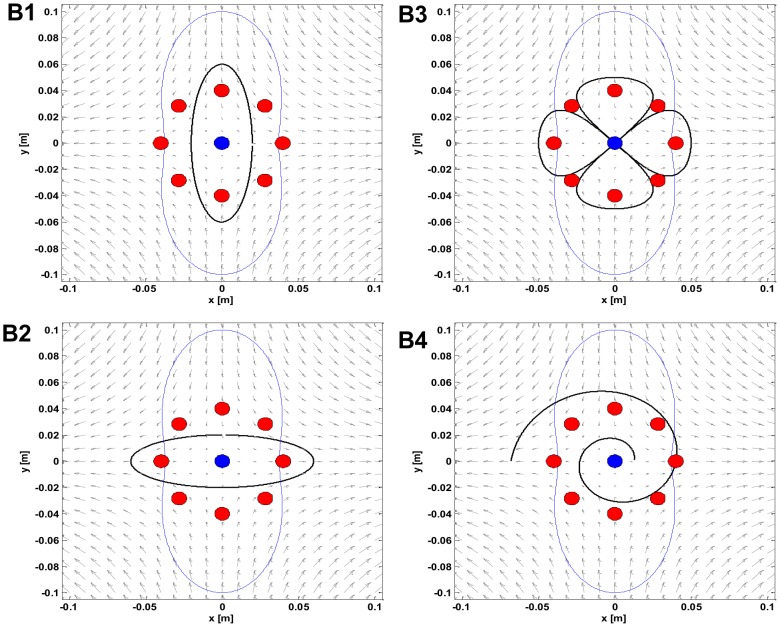
Layout of the targets in the different tasks.In all the panels the eight peripheral targets (in red) and the central parget (in blue) are related to task A. The four panels depict the target trajectories (in black) to be tracked in tasks B. Panel B1: Vertical ellipse (swept in the CCW direction). Panel B2: Horizontal ellipse (CCW). Panel B3: Clover (CW, CCW, CCW, CW). Panel B4: Spiral (CCW). In all the panels in the background there is the force-field and the peanut-shaped locus of marginal stability (in blue).